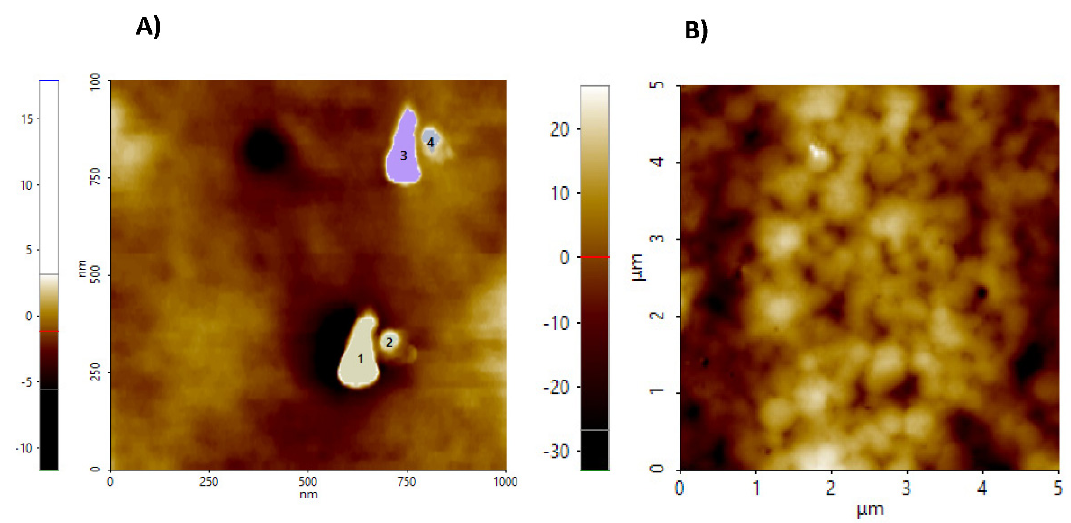
Figure 3. (A ) Cellulose nanocrystals showing the selected particles size range of 74.63–128.85 nm. ( B ) Films of cellulose nanocrystals and chitosan (NC-CH).